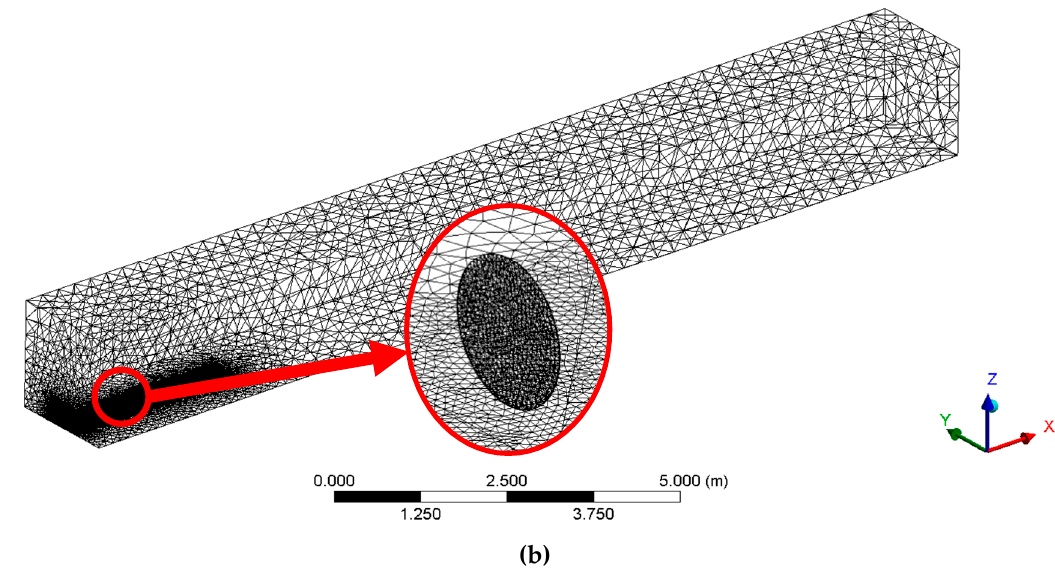
Figure 2. CFD configuration of model: ( a ) computational domain; ( b ) grids system.